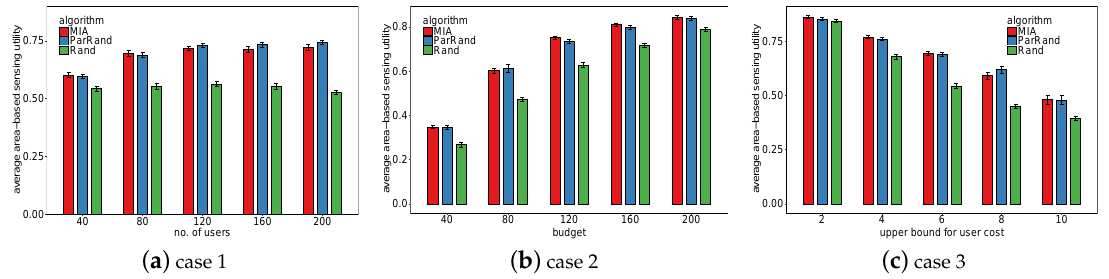
Figure 8. Comparison of the three algorithms in coverage area-based sensing utility.